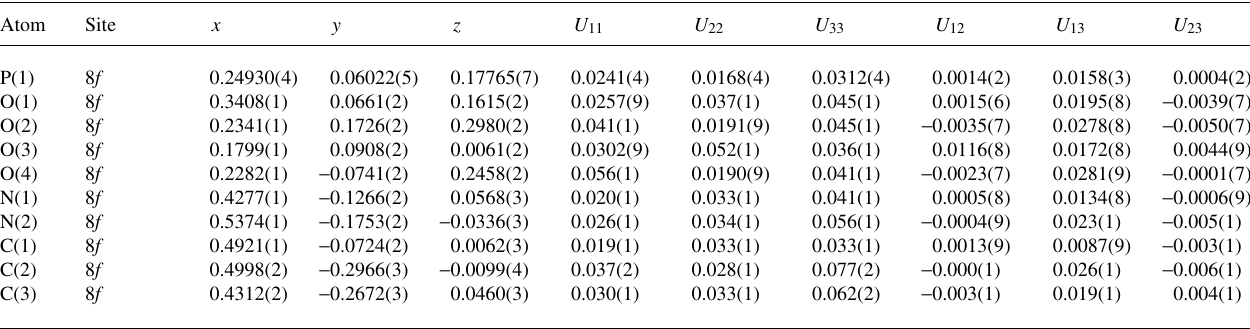
Table 3. Atomic coordinates and displacement parameters (in Å 2 )